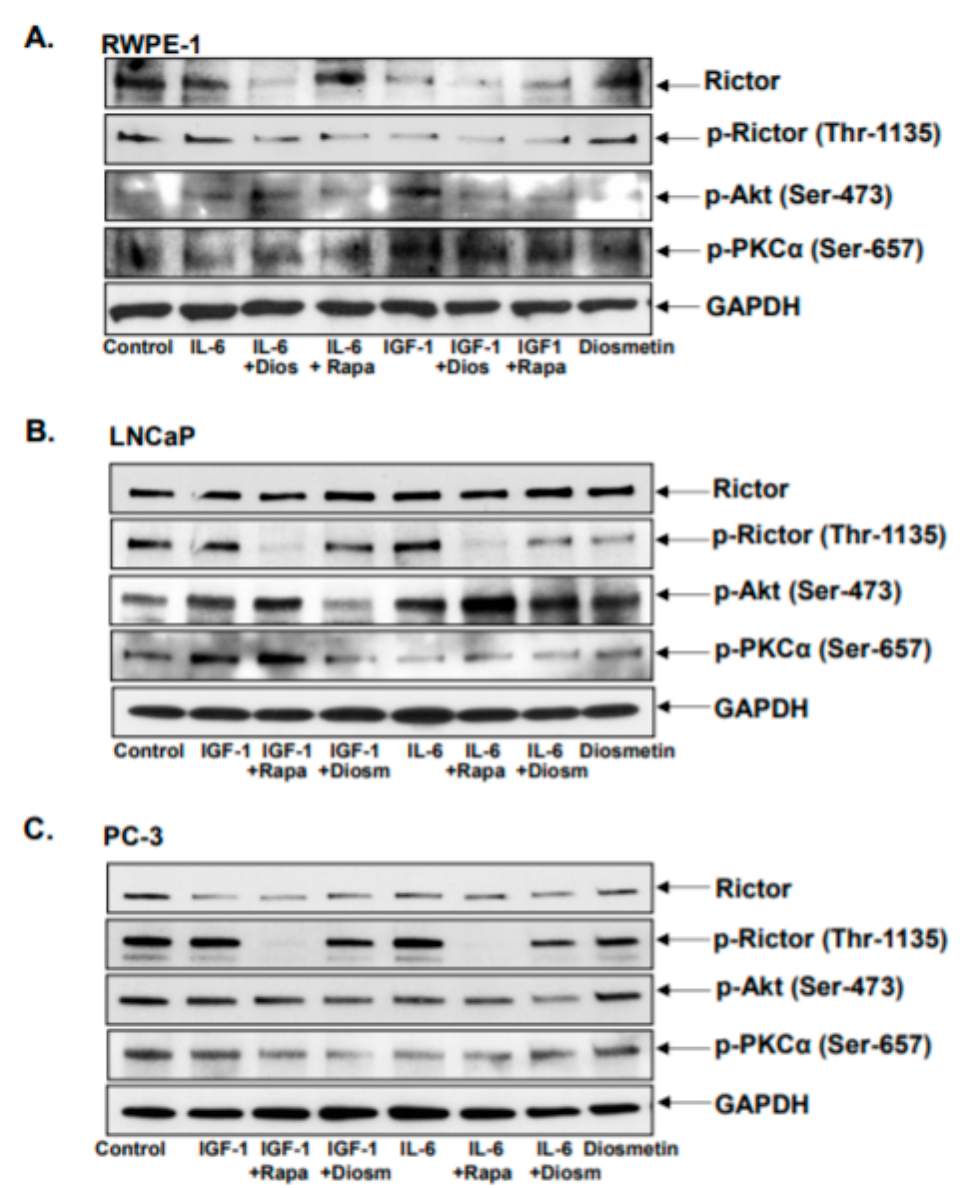
Figure 5. Combinatorial effect of diosmetin with IGF-1 and IL-6 in prostate cancer cells. LNCaP ( B ) and PC-3 ( C ) prostate cancer cells, and normal prostate epithelial cells (RWPE1) ( A ) were pretreated with Rapamycin (10 nM) and Diosmetin (20 µ M) for 30 minutes. These cells were later treated with IGF-1 (20 ng concentration to LNCaP and PC-3, and 10 ng to RWPE1 cells) and IL-6 (5 ng concentration to LNCaP and PC-3 cells, and 10 ng to RWPE1 cells). After 24 h, total lysates were made to determine the protein expressions of Rictor, p-Rictor (Thr1135), p-AKT (Ser-476), and p-PKC α Ser-657. For protein loading, control blots were stripped and reprobed with GAPDH.